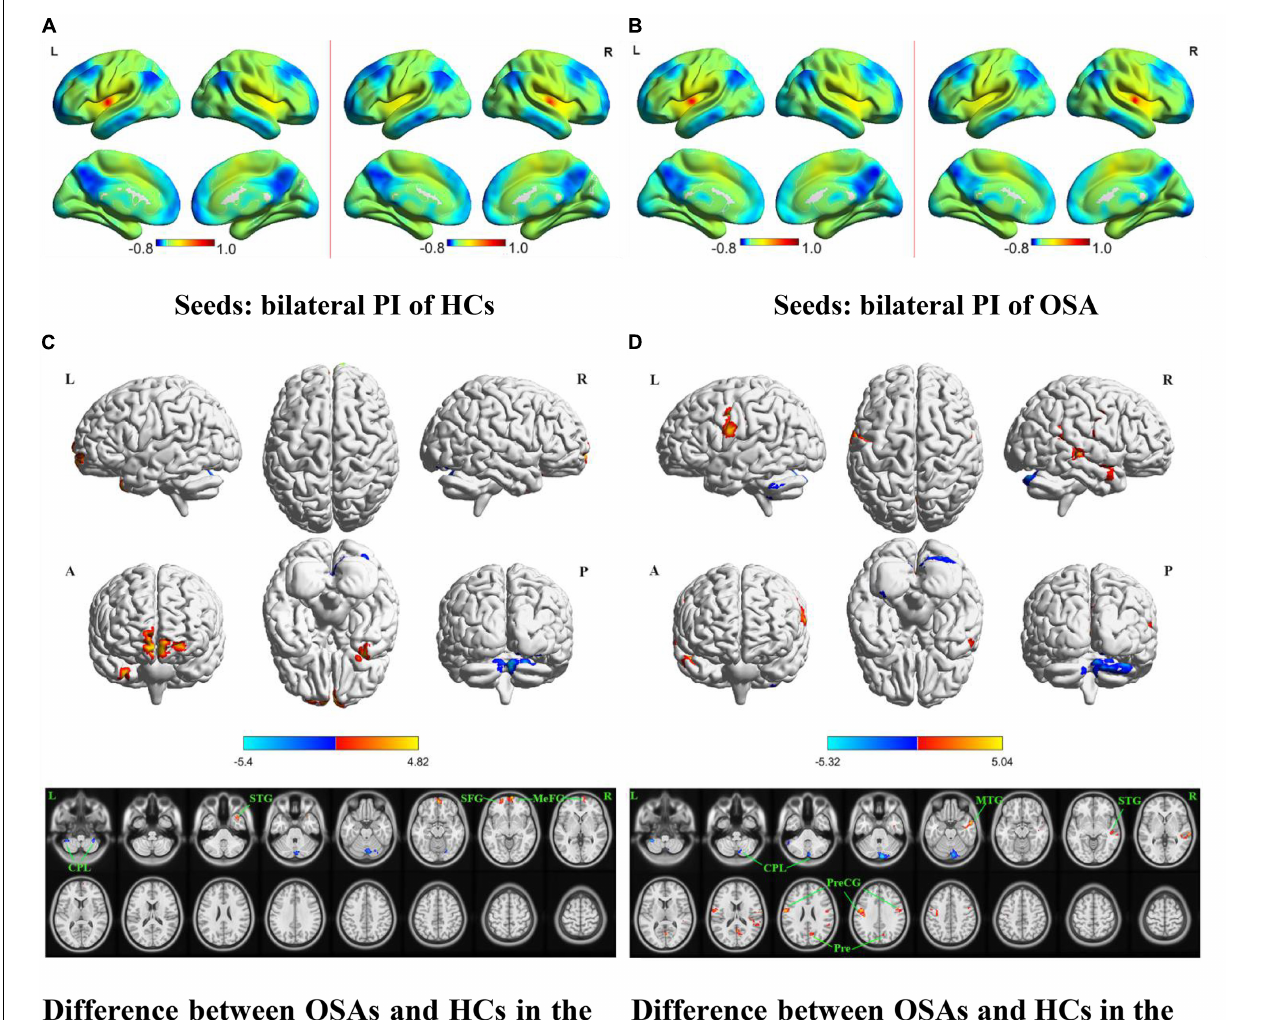
FIGURE 3 | The spatial distribution of the FC maps of the bilateral PI in the two groups and between-group comparisons of the rs-FC of the bilateral PI. The FC patterns of the bilateral PI in the HC and OSA groups are shown in (A,B) , respectively. Color bars indicate z -values; warmer colors indicate higher z -values relative to the whole-brain average, while colder colors indicate lower z -values. (C) Denotes the altered FC based on the left PI seed in OSAs relative to HCs. (D) Denotes the altered FC based on the right PI seed in OSAs relative to HCs (voxel-level P < 0.001, AlphaSim corrected). Color bars indicate t-scores; warm colors indicate areas where the FC value in OSAs is greater than that in HCs, while cold colors indicate the opposite. HCs, healthy controls; OSAs, obstructive sleep apnea patients; PI, posterior insula; FC, functional connectivity; SFG, superior frontal gyrus; MeFG, medial frontal gyrus; STG, superior temporal gyrus; MTG, middle temporal gyrus; PreCG, precentral gyrus; Pre, precuneus; CPL, cerebellum posterior lobe; L, left; R, right; A, anterior; P,